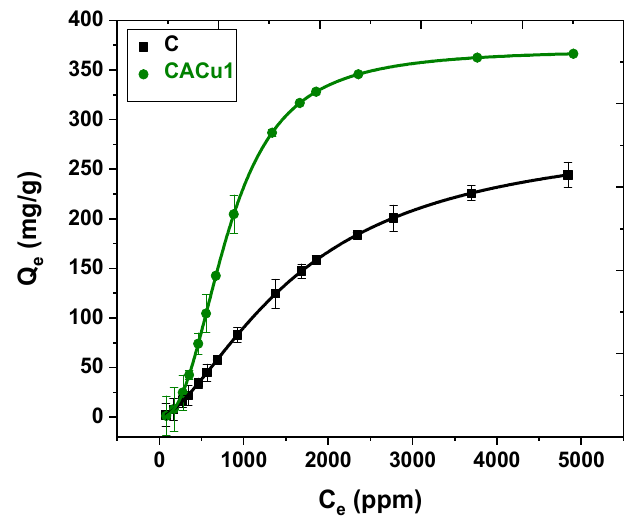
Figure 6. Sips isotherm profiles of C and CACu1 at 298 K and pH 6.8 for adsorption of sulfate from aqueous solution.